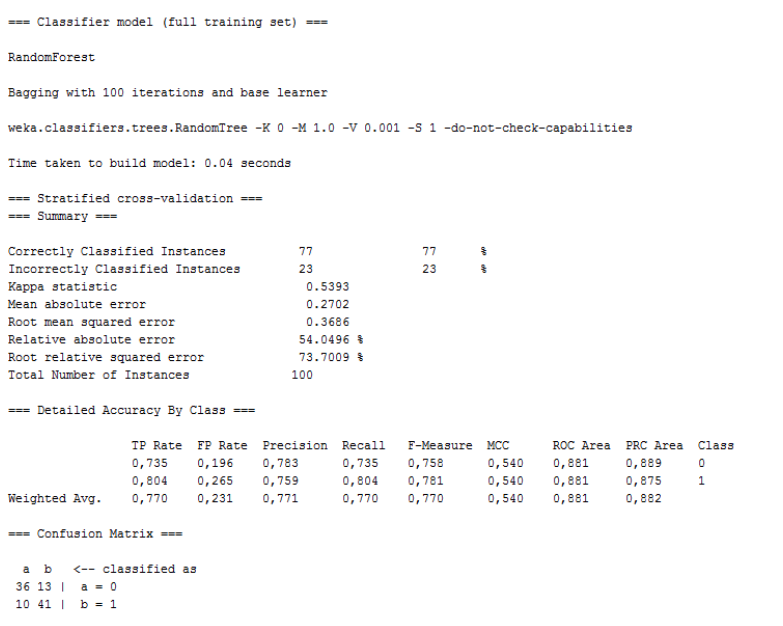
Figure A5. Random Forest Results for the General